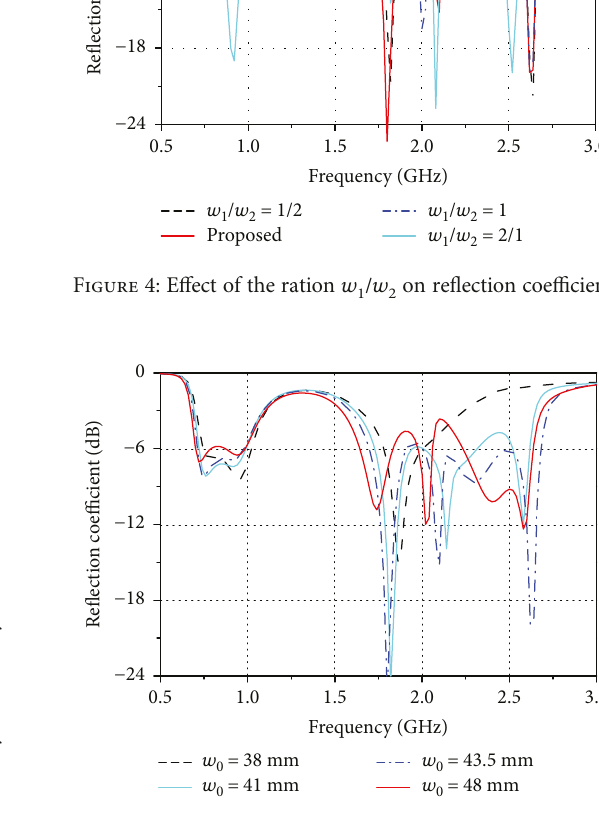
Figure 5: Simulated re fl ection coe ffi cient for the proposed antenna as a function of w . 0